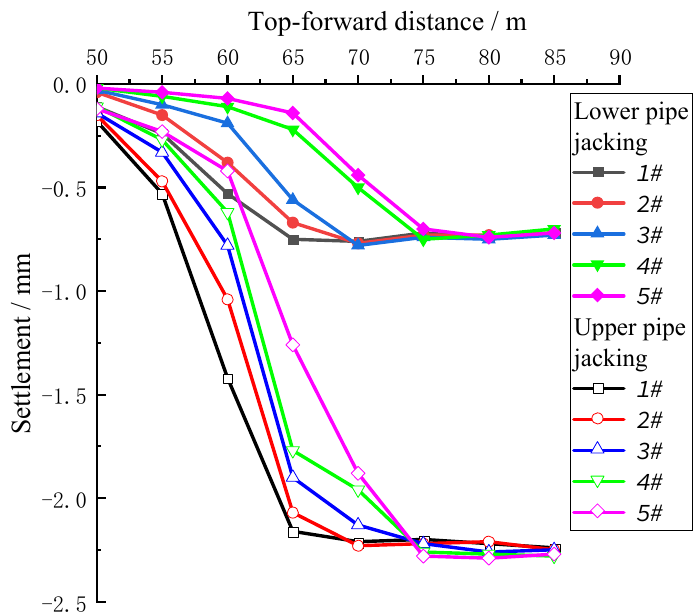
Figure 5. Longitudinal surface settlement.